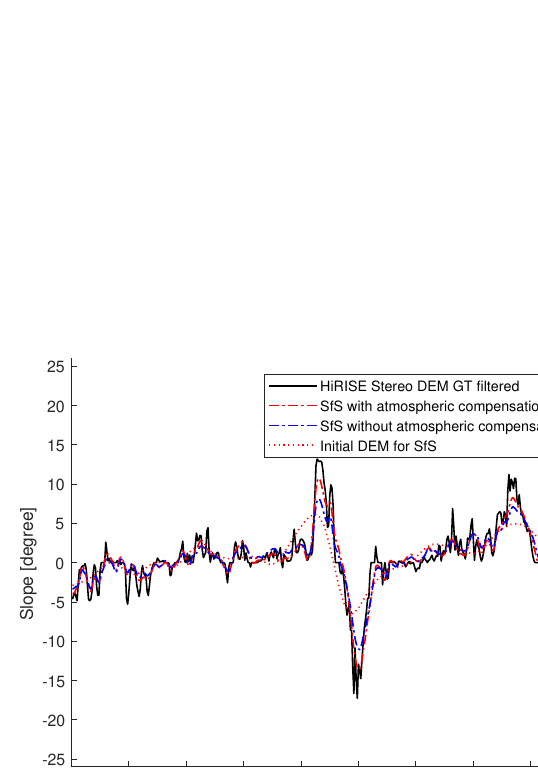
Figure 5. Slope map of the stereo DTM.